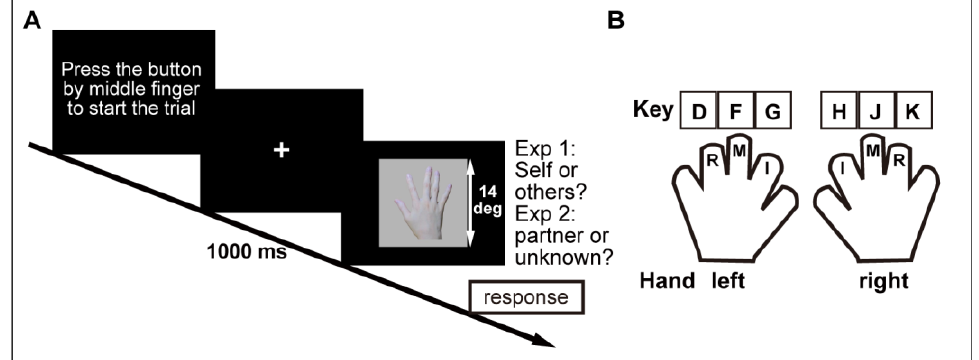
Figure 1. Experimental protocol. ( A ) Time sequence of the trial. ( B ) Finger configuration for key response. I, M, R denote index, middle, and ring fingers, respectively.